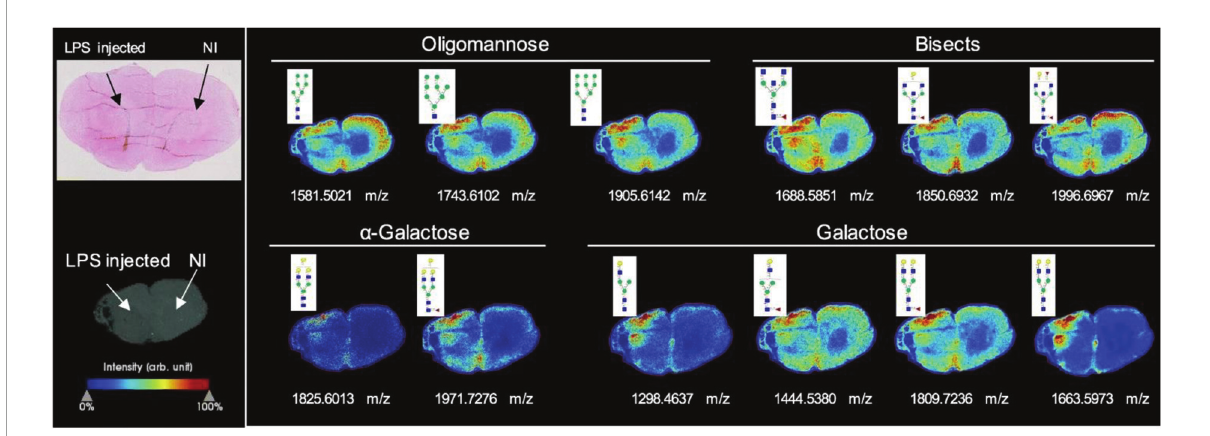
FIGURE1 N-glycan imaging of the brain of LPS-injected rats. Main N-glycan structures that are visualized in the lesion core belong to specific groups: oligomannose, bisected structures, and galactosylated glycans, mainly with α -galactose. Each image is accompanied by the putative structures determined by combinations of accurate m/z, CID fragmentation patterns, and glycan database structure. NI stands for none injected area. Reprinted with the permission from Rebelo et al.